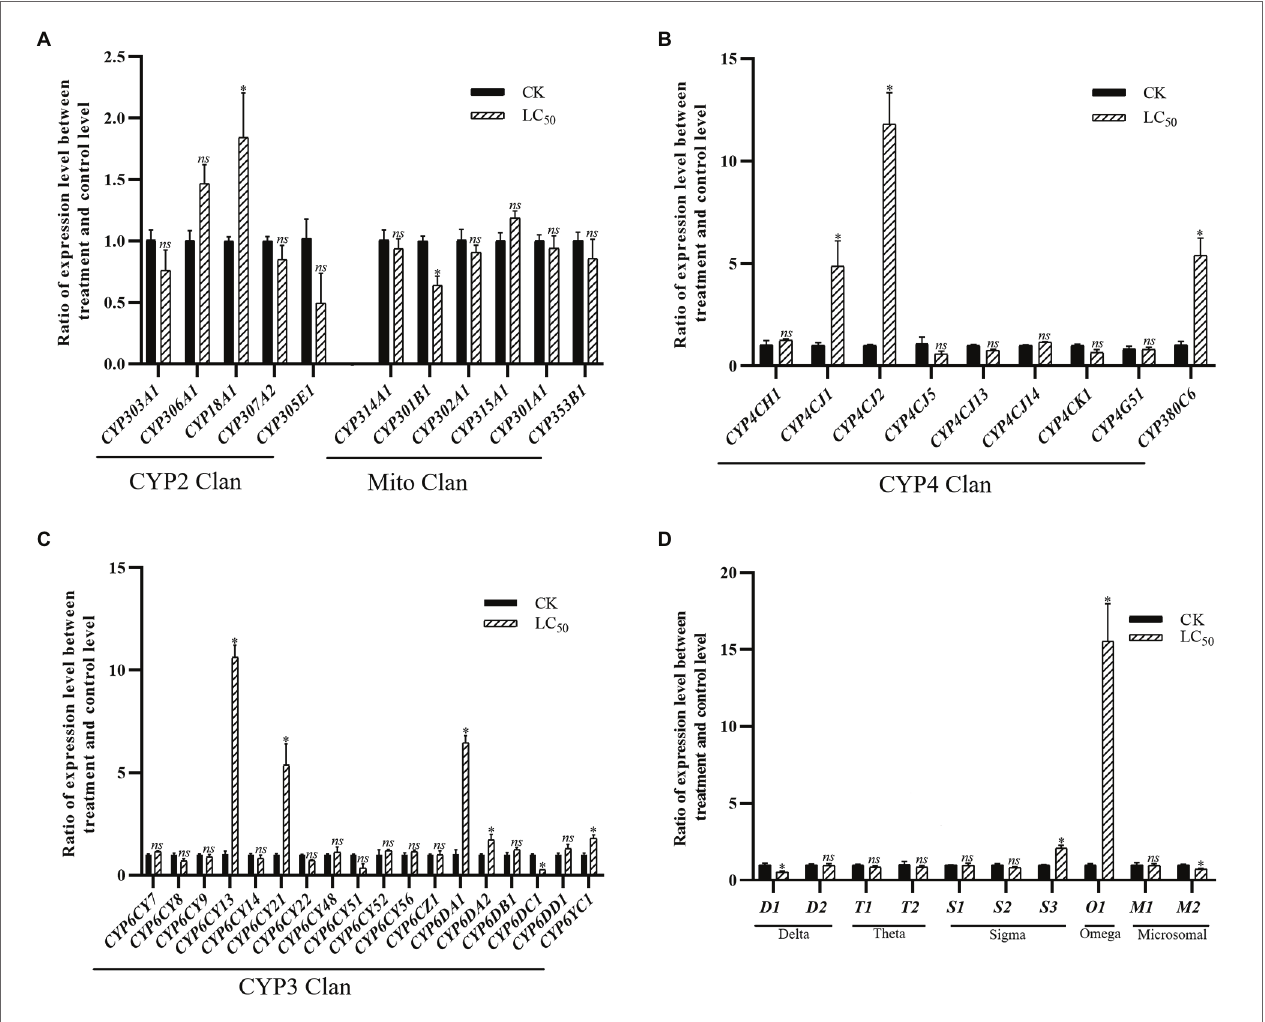
FIGURE 4 | Fold changes in the expression of 38 P450 genes and 10 GST genes in the A. craccivora susceptible strain after the LC 50 dose of imidacloprid treatment. The significant differences were marked by asterisks. *Significantly at 0.05 level. The ns represents no significant difference. (A) Fold changes in the expression of P450 genes from CYP2 and Mito Clan. (B) Fold changes in the expression of P450 genes from CYP4 Clan. (C) Fold changes in the expression of P450 genes from CYP3 Clan. (D) Fold changes in the expression of GST